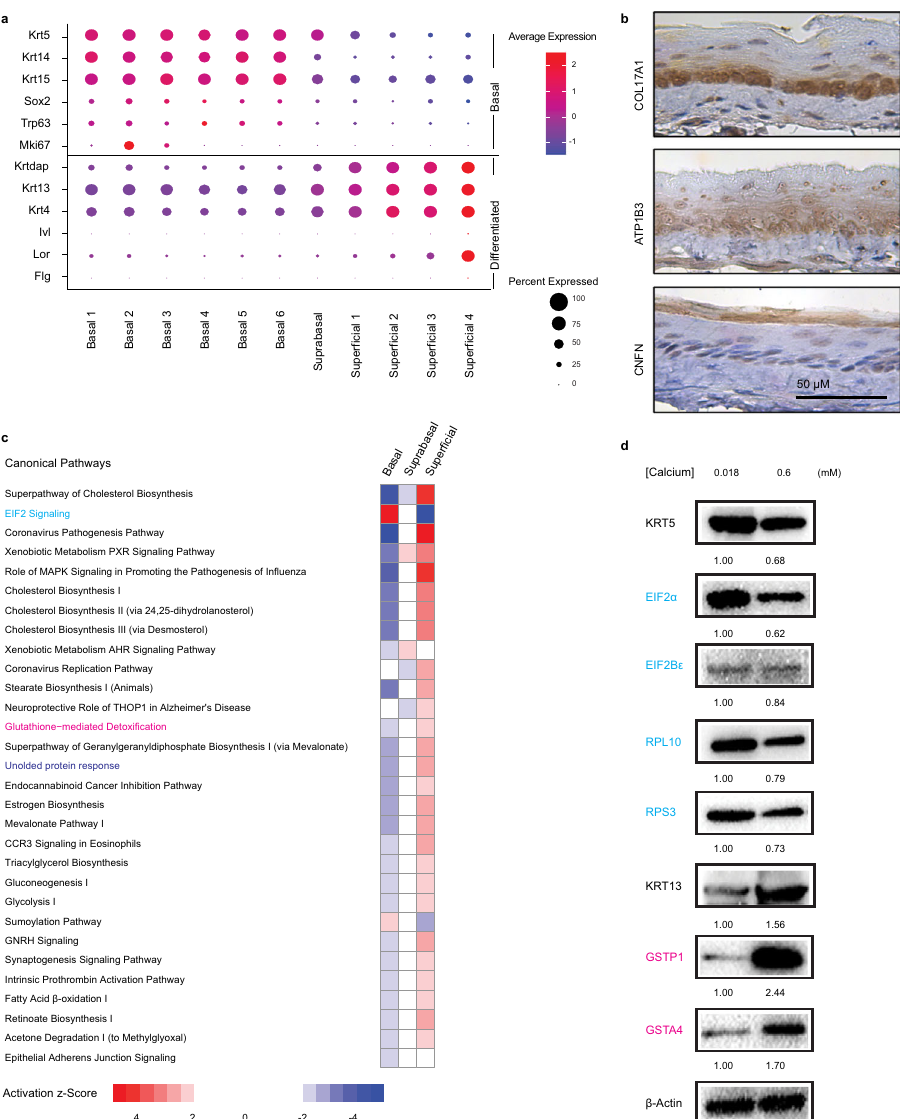
Fig. 2 Molecular characterization of the basal/differentiated cell axis in murine esophageal epithelium. a Cluster-average expression z-scores of putative basal and differentiated markers. Circle size re fl ects percentage of cells with non-zero expression level for indicated genes. Color intensity re fl ects average expression level across all cells within each cluster with red indicating enrichment and purple indicating inhibition. b Immunohistochemistry for indicated proteins in murine esophageal epithelium ( n = 6 animals). Scale bar, 50 µ m. c Ingenuity pathway analysis prediction of canonical pathways and their activation state in each cell types. In heat map, ranking is based upon activation z-score and color intensity depicts relative value of activation z-score. A positive value (red) indicates activation while a negative value (blue) indicates inhibition of the respective pathway. d Western blot analysis of representative proteins involved in eukaryotic initiation factor (EIF) 2 signaling and glutathione-mediated detoxi fi cation in primary murine esophageal keratinocytes cultured in media with indicated calcium concentrations. Densitometry determined relative level of indicated proteins normalized to β -actin. All experiments were repeated three times independently. Uncropped and unprocessed full scans are included in the source data. Source data are provided as a Source Data fi